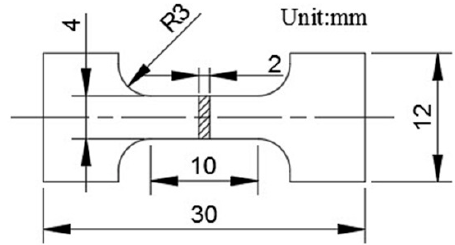
Figure 4. The dimensions of the tensile specimen.